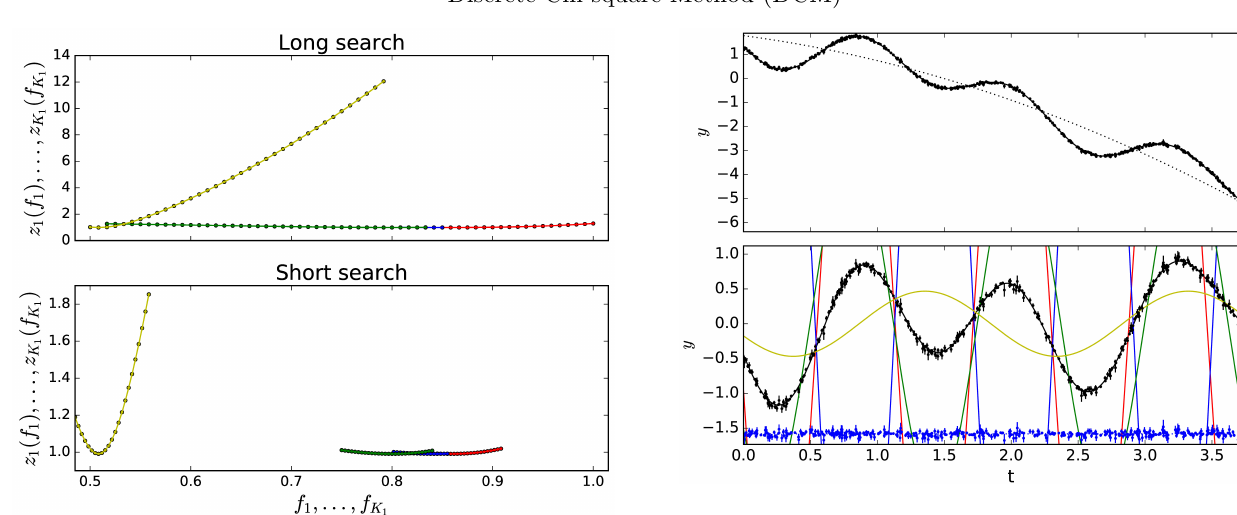
Fig. 5.— Model 27 periodograms z 1 ( f 1 ) ,...,z 4 ( f 4 ) for Table 3 data. Otherwise as in Fig. 2. refer to this as Intersecting frequencies.